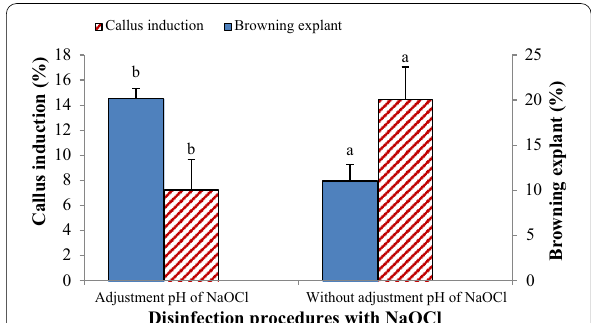
Fig. 5 The effect of NaOCl pH adjustment on M. azedarach L. leaf explant disinfection and in vitro culture responses in the media containing benomyl. Bars with different letters indicate a significant difference ( P 5%) according to Duncan’s Multiple-Range Tests ≤